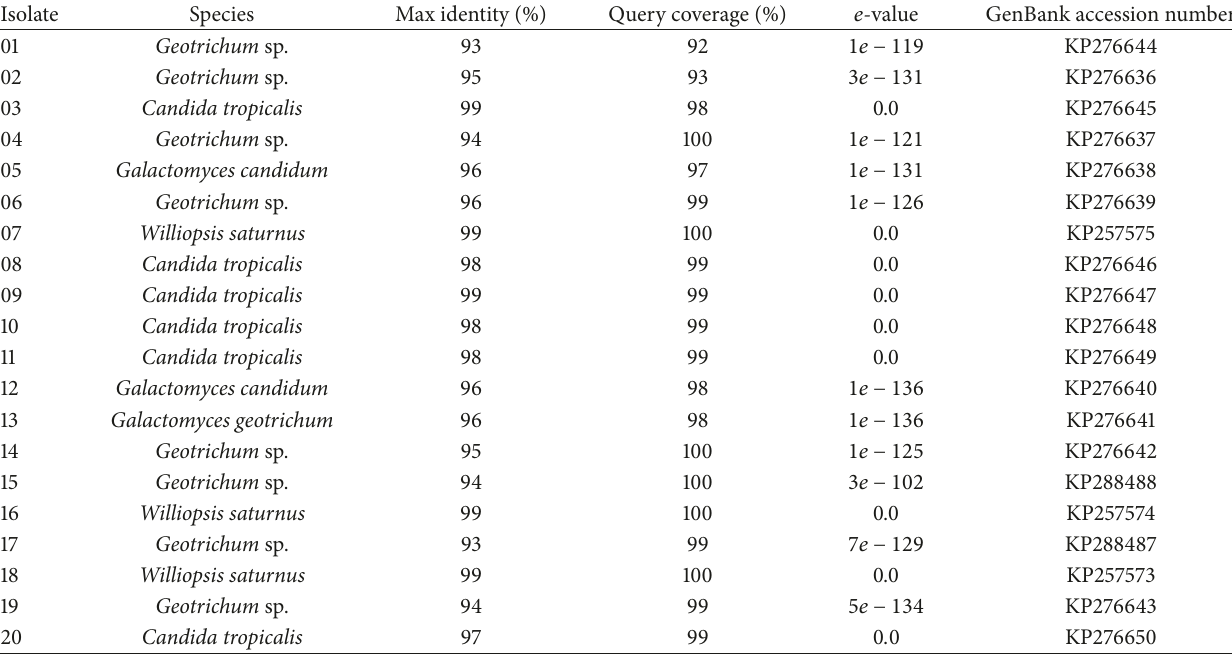
Table 2: Identification of isolates according to BLAST result and nucleotide sequence GenBank accession number.